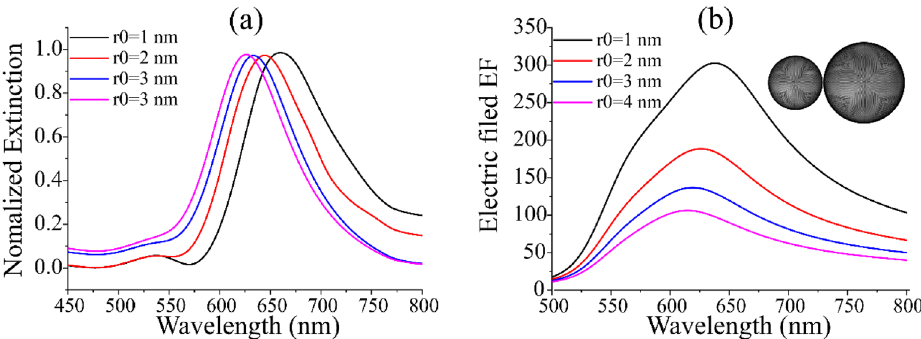
Figure 6. ( a ) Au@Al 2 O 3 extinction spectrum of dimer varying with thickness of Al 2 O 3 at the same radius. The data were normalized. Au@Al 2 O 3 dimer has a radius of 50 nm and a distance of 1 nm. ( b ) Au@Al 2 O 3 dimer curve of electric field enhancement factor of different shell thickness with wavelength of incident light. The dimer radius are 40 nm and 60 nm, respectively.